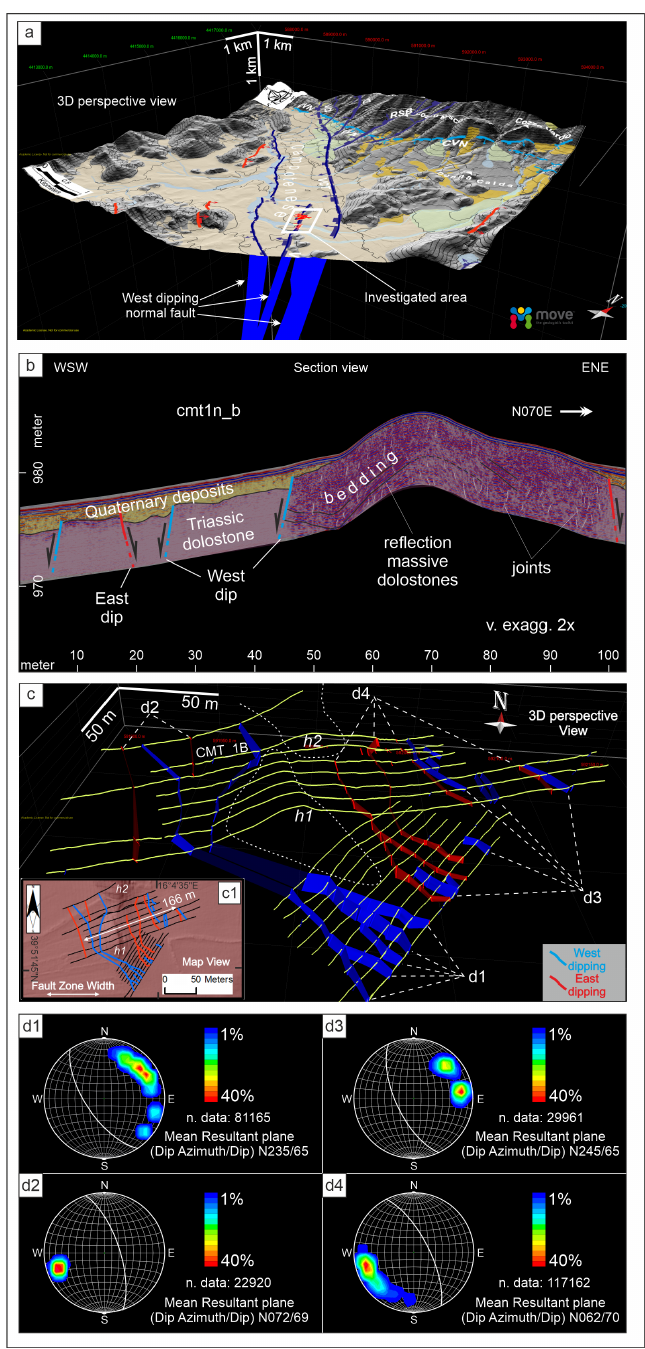
Figure 9. Results of the three-dimensional analysis and interpretation performed on the entire GPR dataset: (a) 3D structural model of the Campotenese basin updated after Brozzetti et al. (2017a) (DTM sources: TINITALY by Tarquini et al., 2012, and by Regione Calabria – http://geoportale.regione.calabria.it/opendata, last access: 11 June 2021, under license IODL 2.0. – https://www.dati.gov.it/iodl/2.0/, last access: 11 June 2021); (b) GPR section view (cmt1n-b) with interpretation including synthetic and antithetic fault splays (blue = W to SW dip; red = E to NE dip, respectively); (c) detailed structural scratch of faults obtained by the analysis and correlation of interpreted fault splays across the entire GPR dataset; the inset c1 is a conventional structural map oriented to the north and reporting the same fault sets to highlight the maximum width derived for the fault zone (d) synthetic stereonet plots of the fault planes in (c) , reporting the mean dip azimuth and dip angle extracted for the identified four main sets of discontinuities, with a dip azimuth ranging between 235–245 and 062–072 ◦ N for the W-dipping and E-dipping normal faults, respectively. Vertical exaggeration is